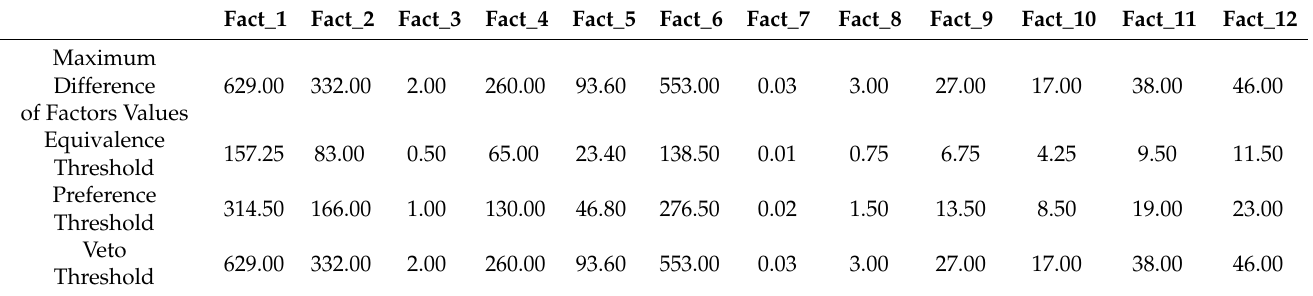
Table 5. The set of equivalence, preference, and veto thresholds from the point of view of the surve- yed men.